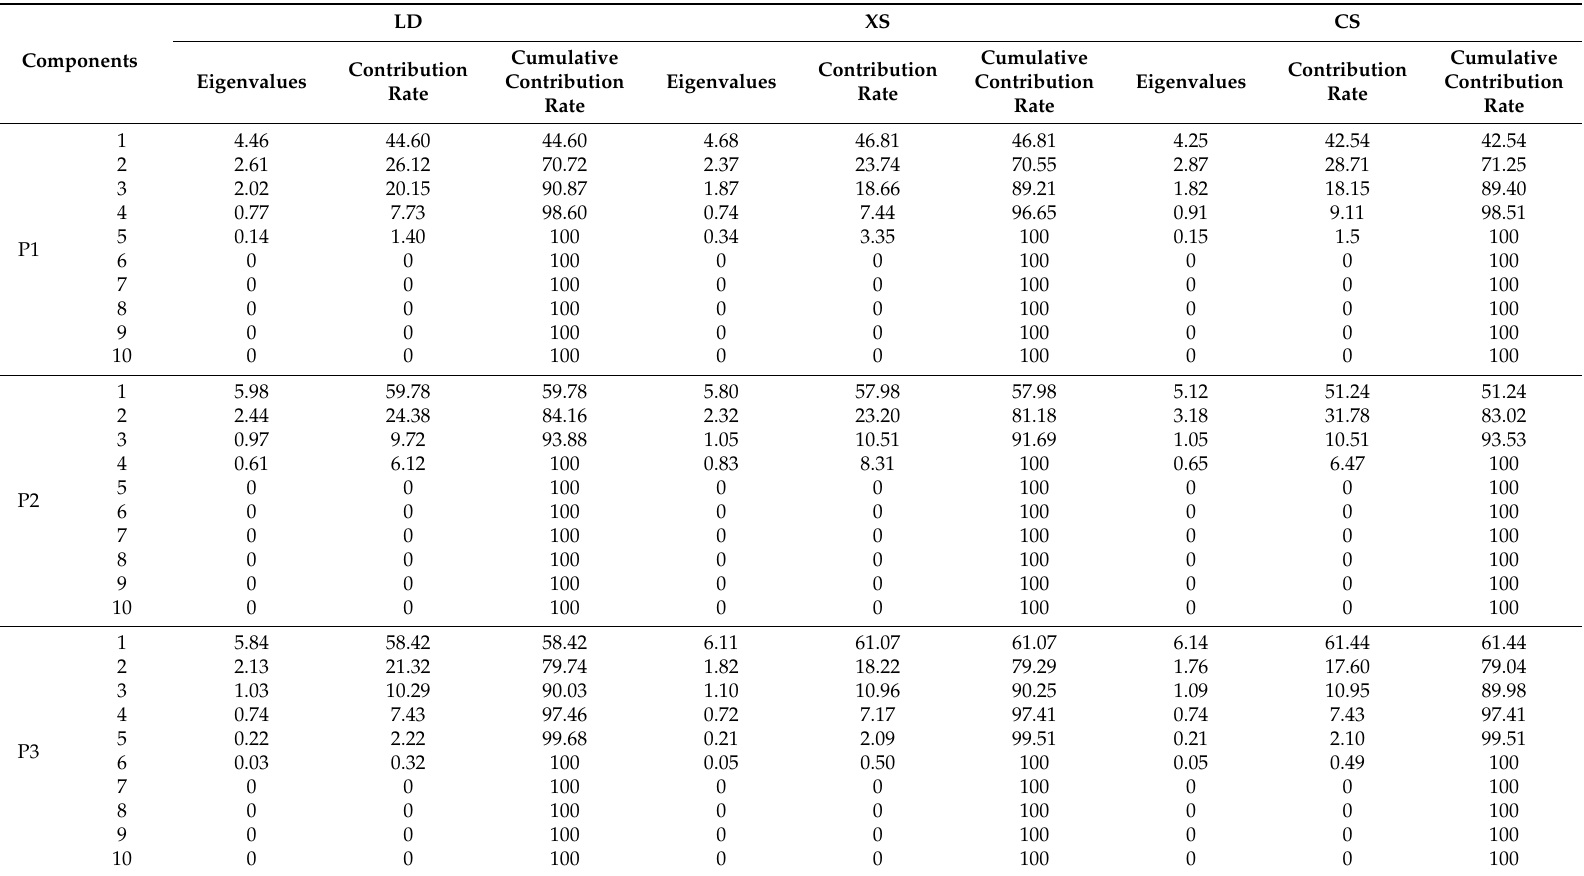
Table A1. Eigenvalue of principal component and cumulative contribution